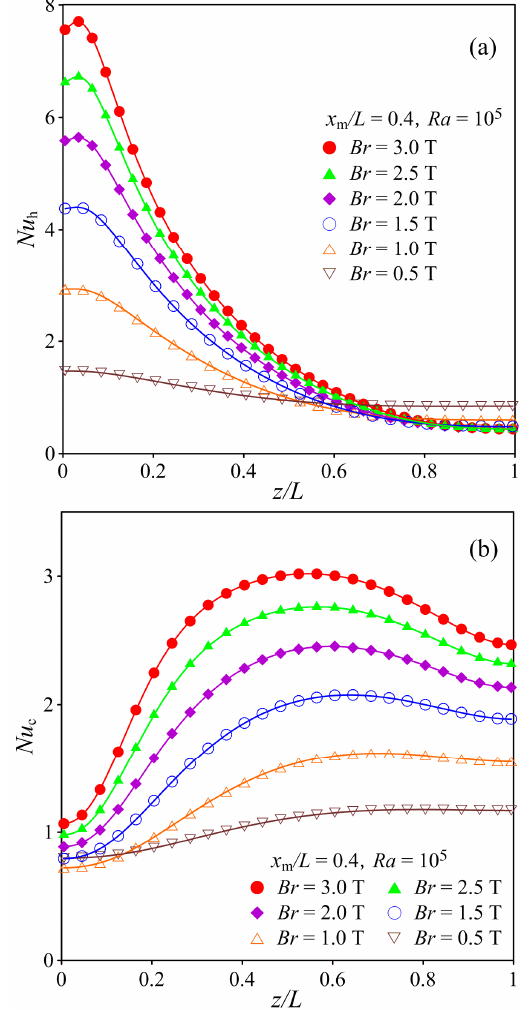
Figure 11. Effect of Br on local Nu on the walls. ( a ) Nu h , ( b ) Nu c .